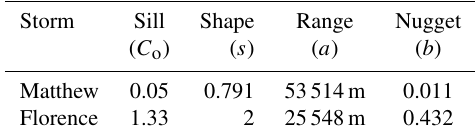
Table 4. Statistics of the stable semivariogram models (see Fig. 6) of (cid:49)t ps-lf for hurricanes Matthew and